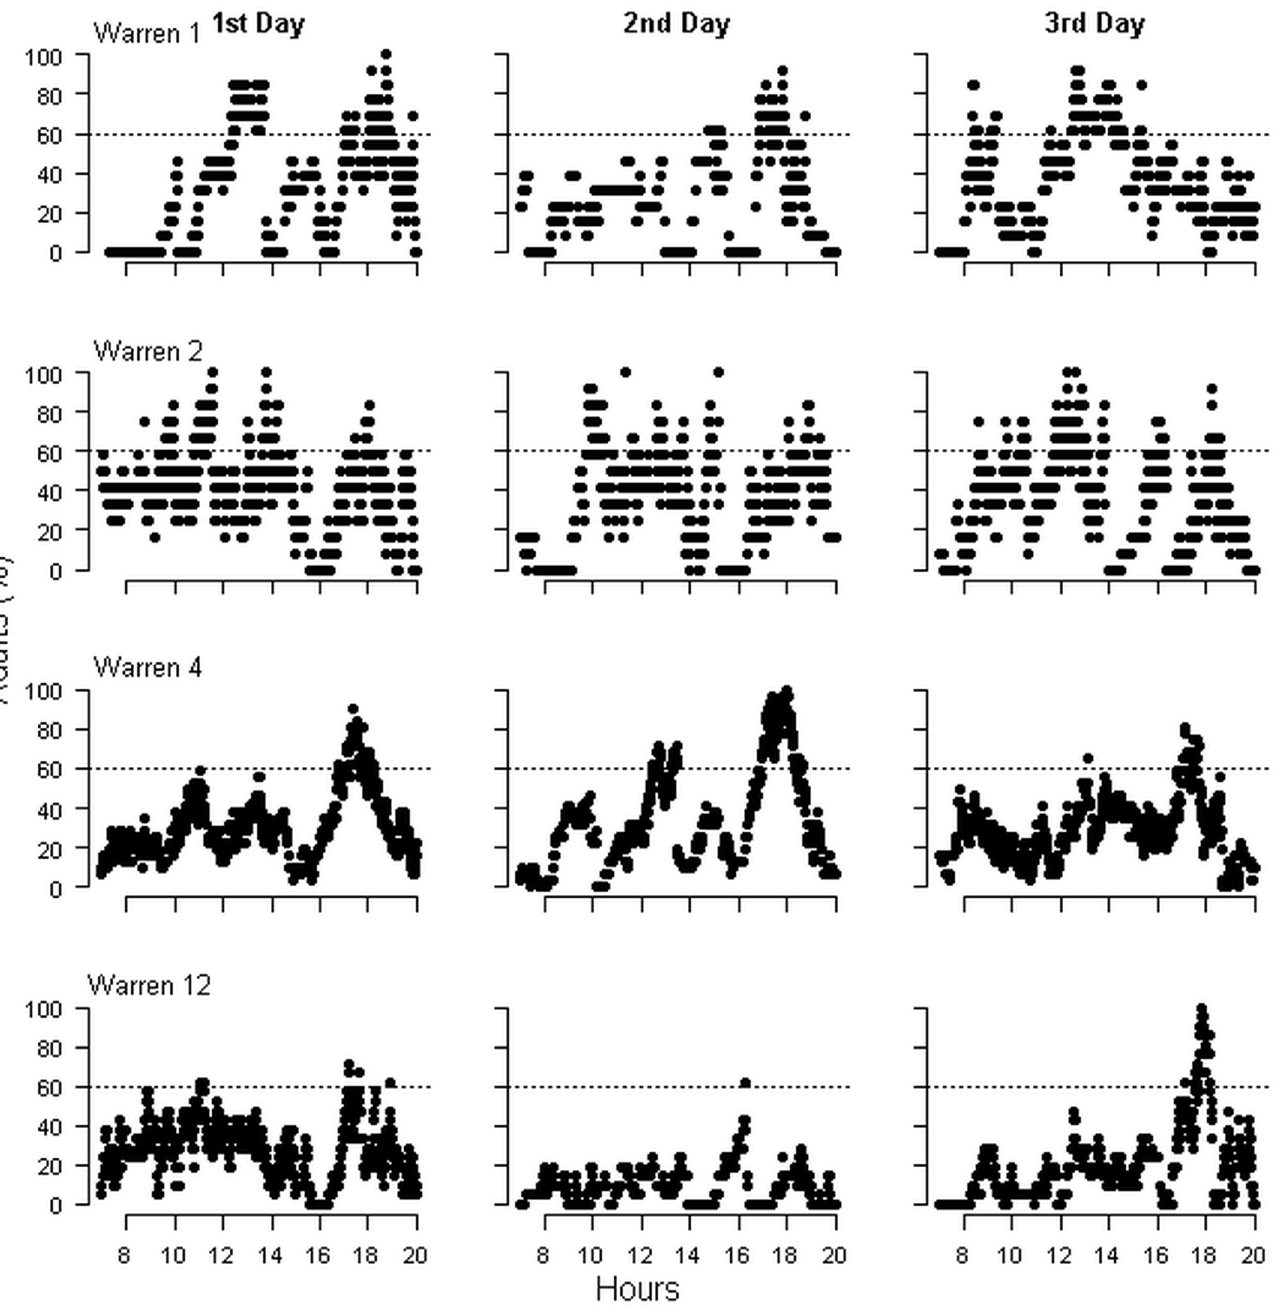
Fig 3. Daily variation in the number of adults registered. Charts show examples of the visiting dynamic of adults to the warren during the three surveyed days in four warrens where resident pups were registered. The maximum number of adults registered within 1-minute intervals is expressed as percentages of the absolute maximum for each warren during the entire study. The dotted line indicates 60% of the maximum